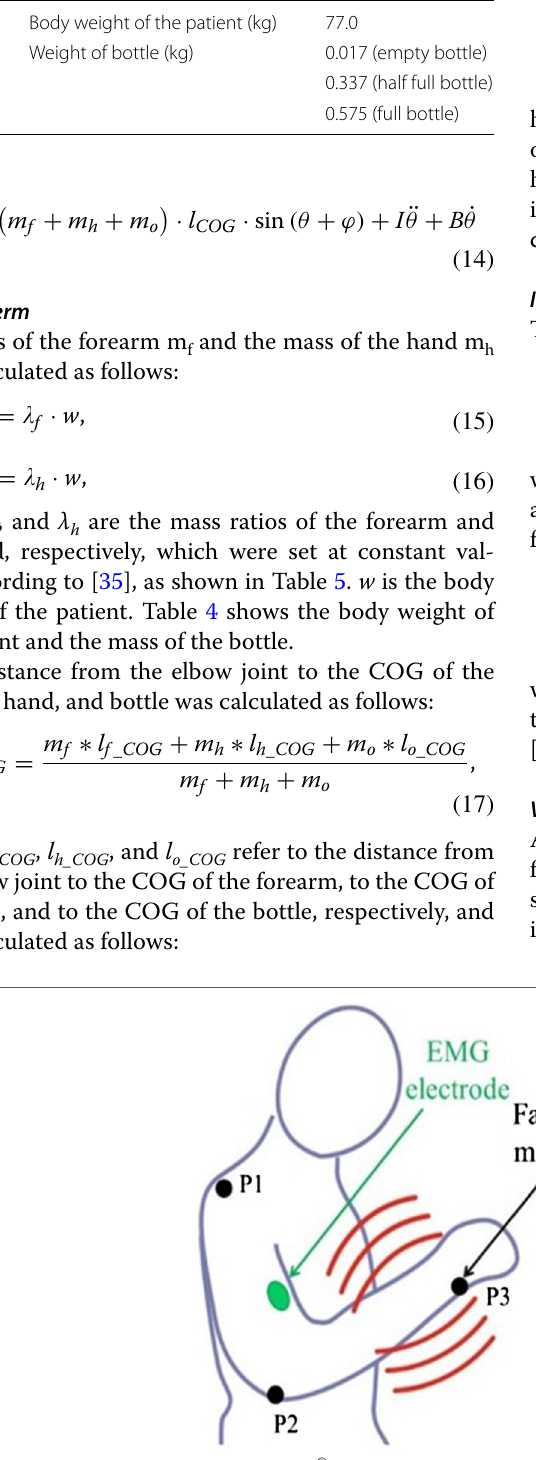
Table 4 Body weight of the patient and weight of the iner- tial load Symbol Detail